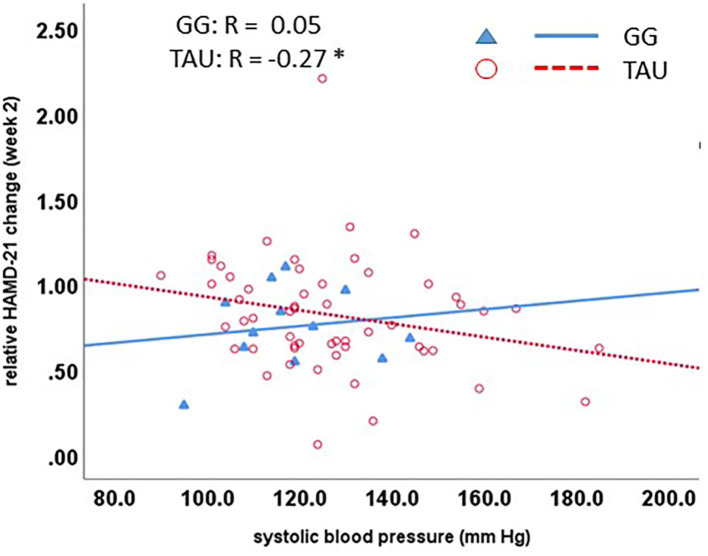
Qualitative patterns for the biomarker-dependent differentiation of clinical outcome between GG-treated and not GG-treated (TAU) subjects. The treatment effect is determined by the ratio of the HAMD-21 at week 2 to that at baseline. A value of 1 refers to no change in HAMD-21; higher values to worsening; and lower values to improvement. Lower systolic blood pressure is related to lesser improvement in the TAU group, but larger improvement in the GG, which leads to a larger differentiation between the groups with lower systolic blood pressure. GG, Glycyrrhiza glabra add-on; TAU, treatment as usual.